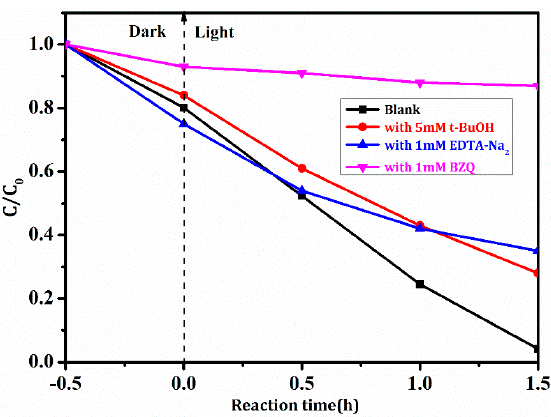
Figure 12. Photodegradation ratios of RhB with BiVO 4 /Mn 1-x Zn x Fe 2 O 4 /RGO under scavengers.